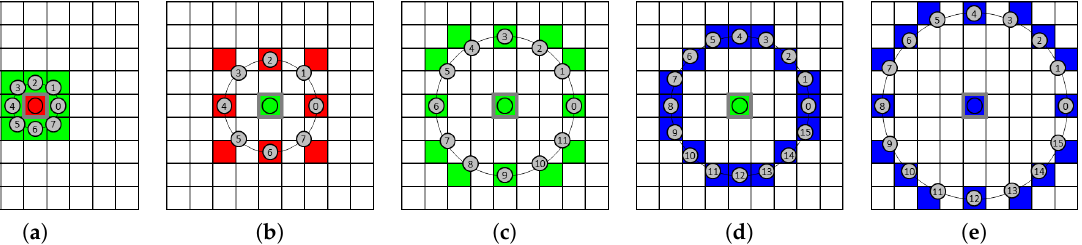
Figure 4. Possible parameter settings of the EOCLBP descriptor in the RGB color space: ( a ) P = 8 and δ = 1 with the ( R , G ) component pair; ( b ) P = 8 and δ = 2 with the ( G , R ) component pair; ( c ) P = 12 and δ = 3 with the ( G , G ) component pair; ( d ) P = 16 and δ = 3 with the ( G , B ) component pair; and ( e ) P = 16 and δ = 4 with the ( B , B ) component